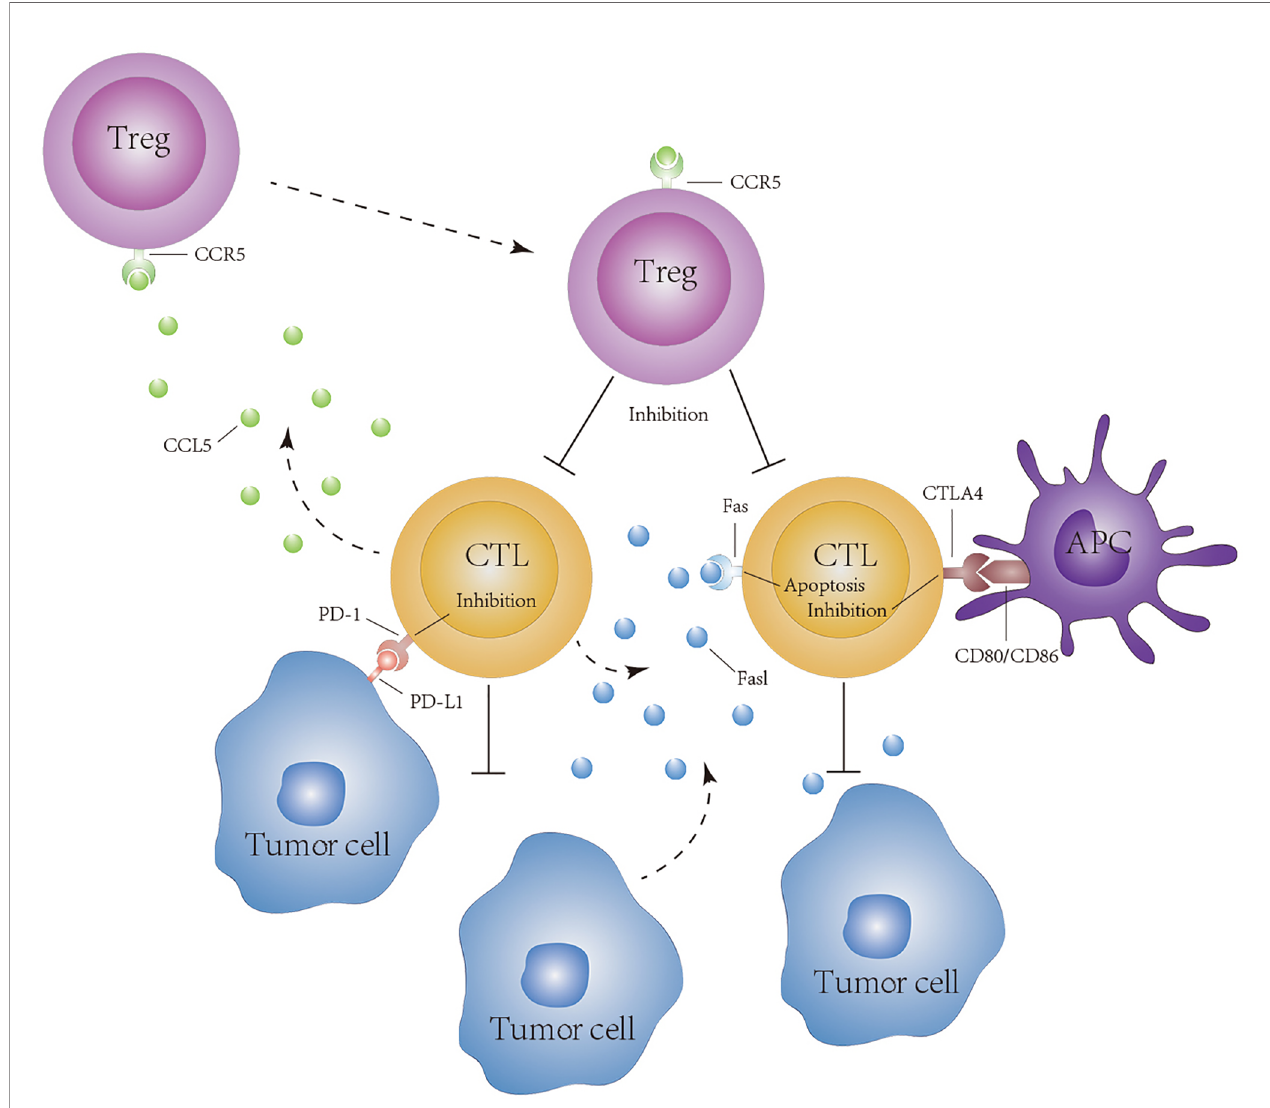
FIGURE 12 | Hypothesis of CD8+ T cell exhaustion in tumors of KIRP patients. PD-1, CTLA4, CCL5, and FASLG reduce the cytotoxicity of lymphocytes to tumor